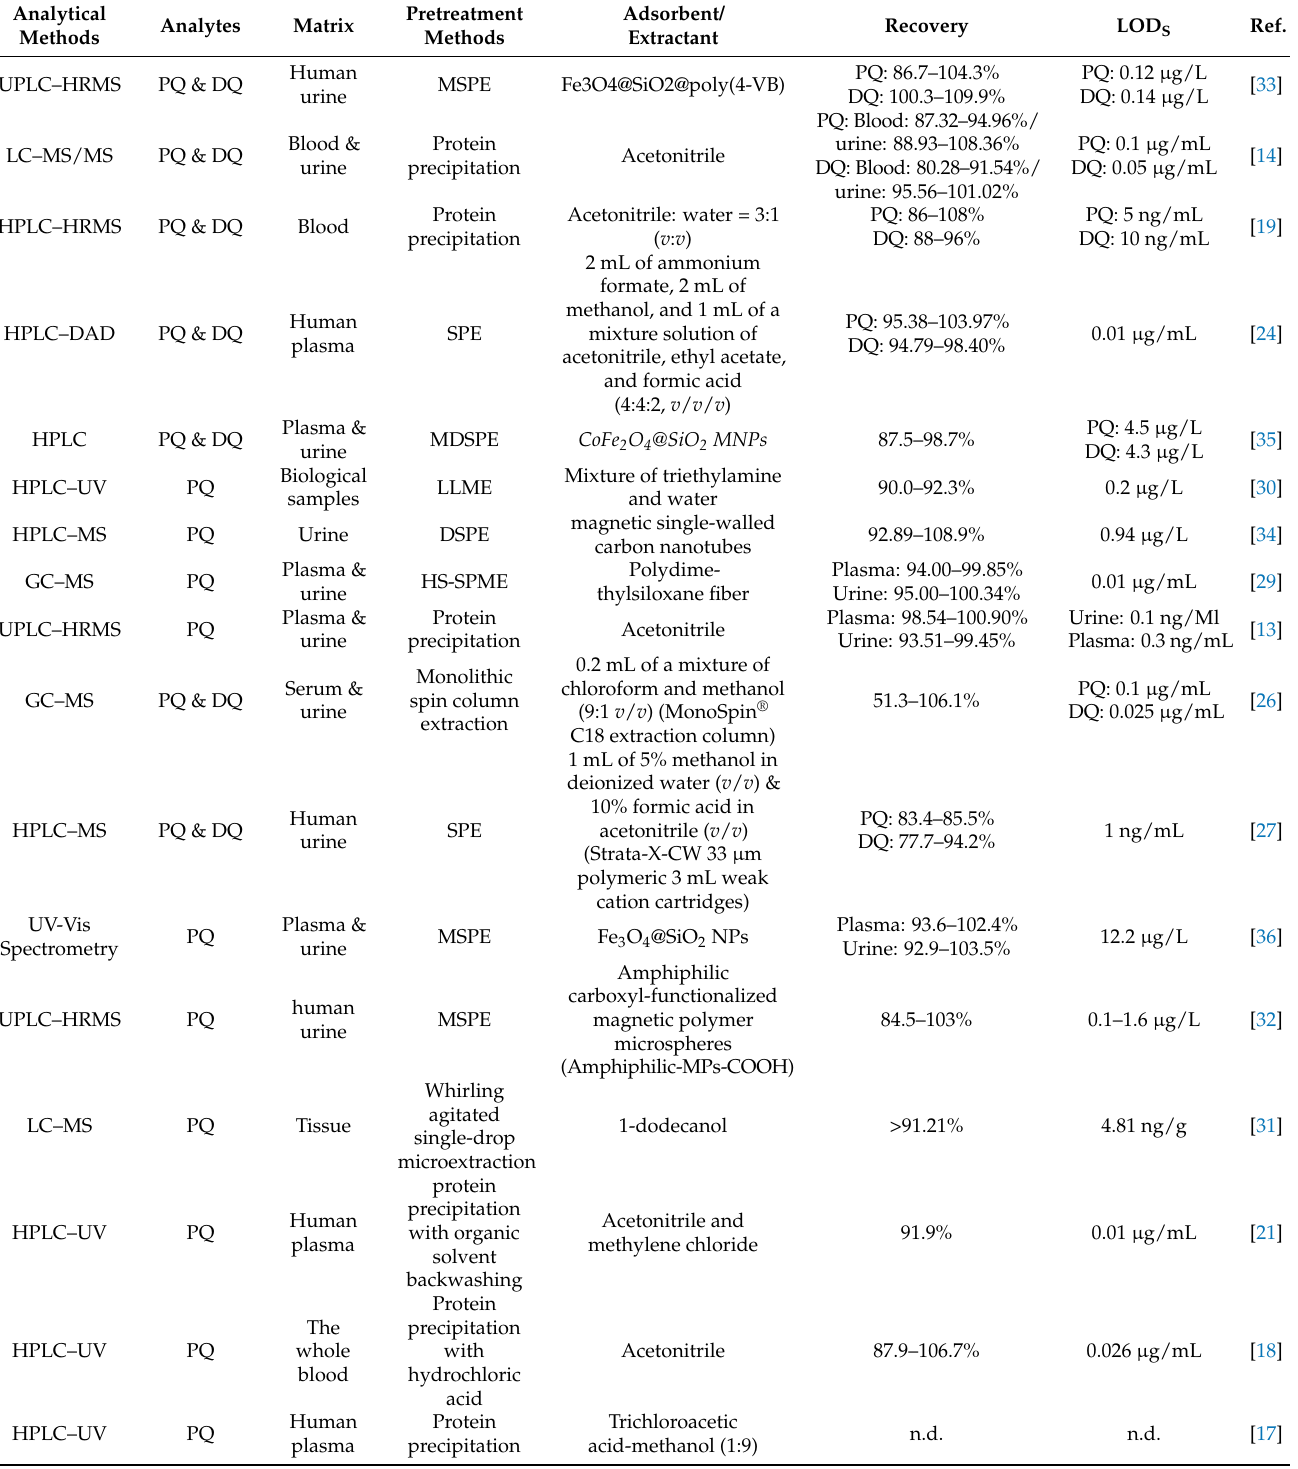
Table 1. Comparison of reported pretreatment methods of PQ and DQ in biological